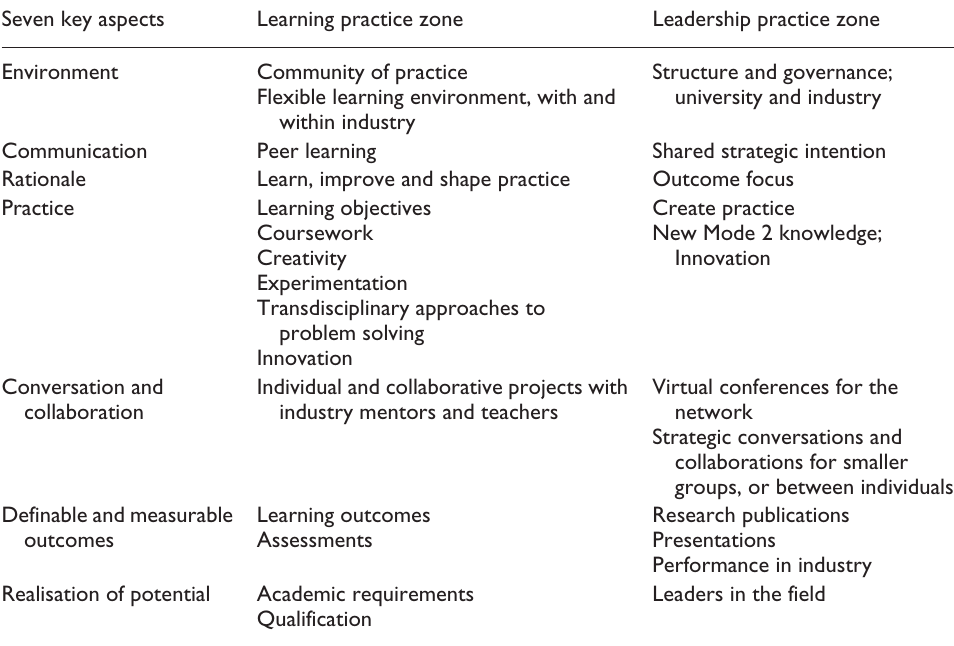
Table 1. Seven key aspects to guide the network manager in creating a strategic knowledge network. Seven key